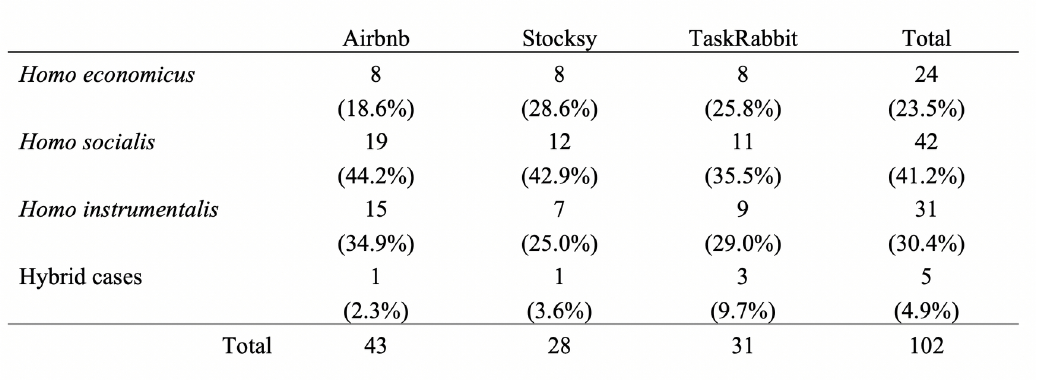
Table 1: Distribution of Behavioral Models Within